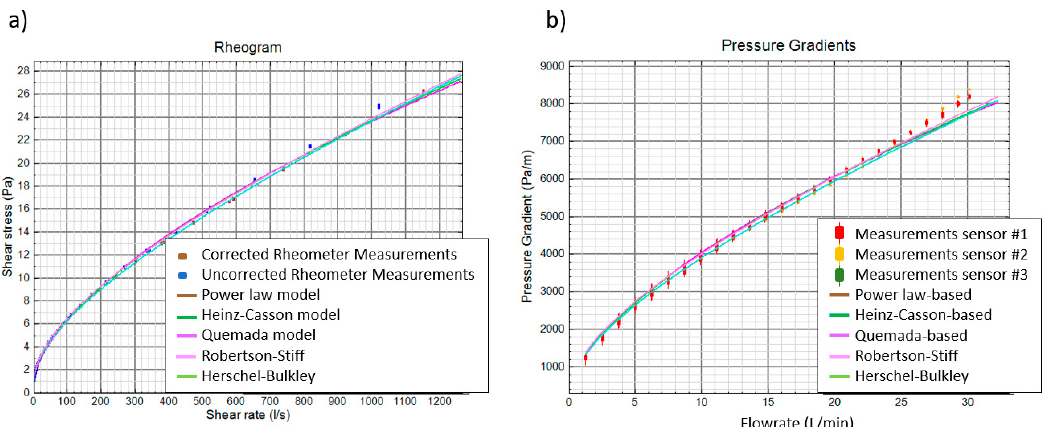
Figure 13. ( a ) rheogram of an aqueous solution of Carbopol with high molecular weight measured at 25 °C with a scientific rheometer, ( b ) comparison between measured pressure gradients with the three di ff erential pressure sensors and pressure gradients calculated with power law, Quemada and Heinz–Casson rheological behaviors.